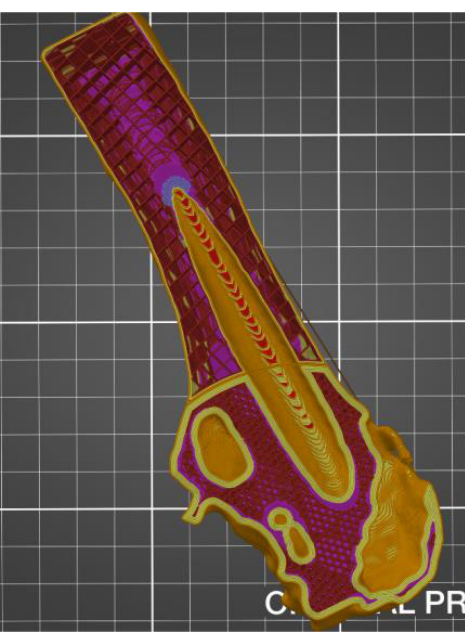
Figure 11. View of the anatomical model of the part of the femoral bone in the working space of the PrusaSlicer silver with the added modifier rendering it possible to change selected parameters.